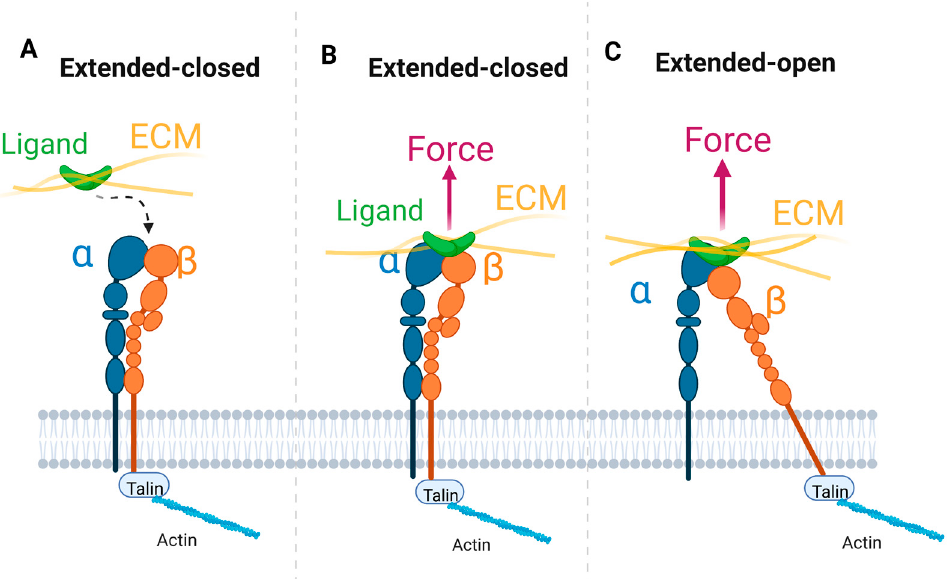
Figure 4. Effect of ECM ligand binding and pulling on integrin conformation. A. Schematics of talin-bound integrin in extended-closed conformation. B. Once the extended-closed conformation of integrin attaches to an ECM ligand, a membrane-normal force is exerted. C. ECM pulling may shift the conformation to the extended-open with swing-out of the hybrid domain. A single integrin is shown here; note, however, that integrins usually function in clusters.